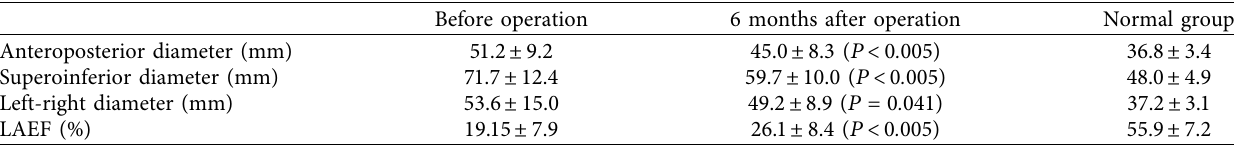
Table 1: Comparison of left atrial structure and ejection fraction before and 6 months after operation. Before operation